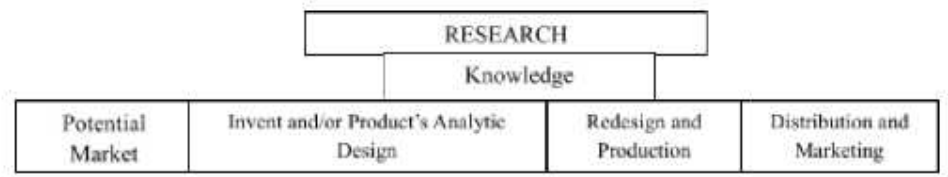
Fig 1 Chain-link model of innovation taken from Suryono and Tohani (2016)